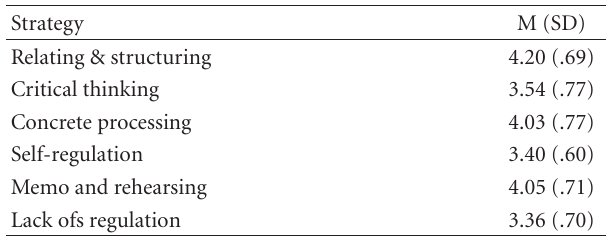
Table 5: Study strategy